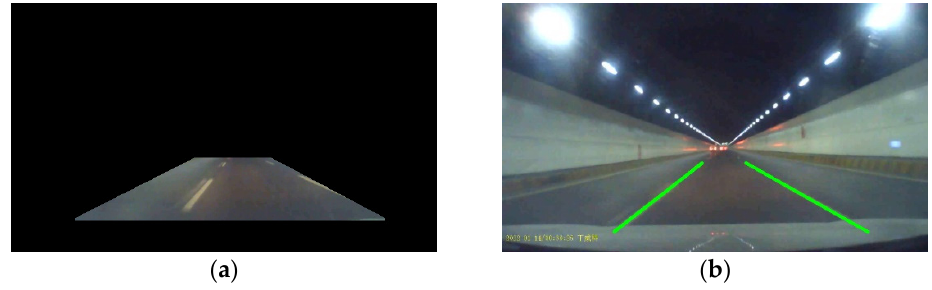
Figure 5. Actual photo of lane in tunnel: ( a ) Vehicle ROI figure; ( b ) Lane Line Fitting Diagram.